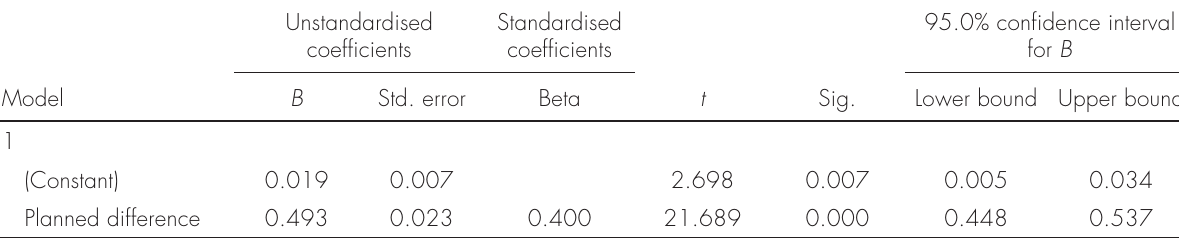
Table VI. Linear regression of planned difference and shortfall in achieved difference.